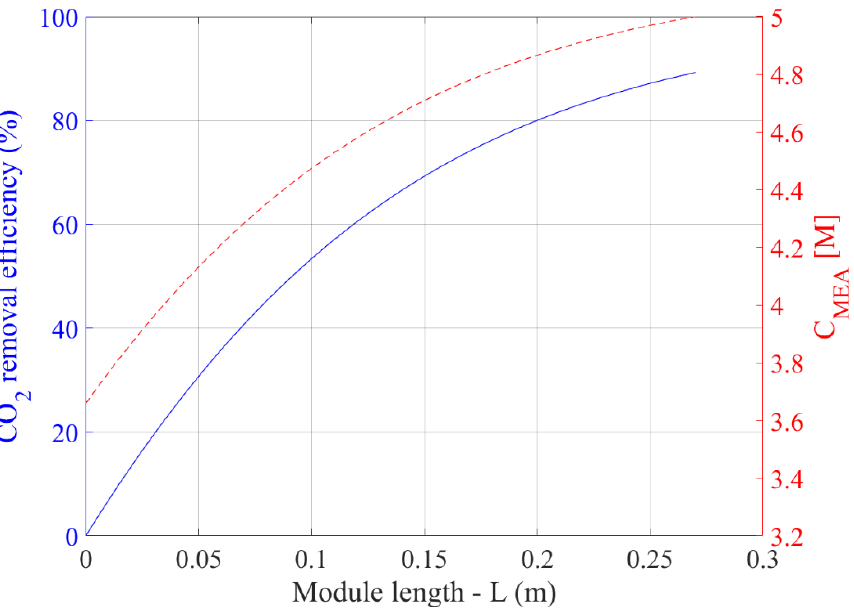
Figure 8. CO 2 removal efficiency and MEA concentration in liquid phase over the module length, Q L = 25L · h − 1 .